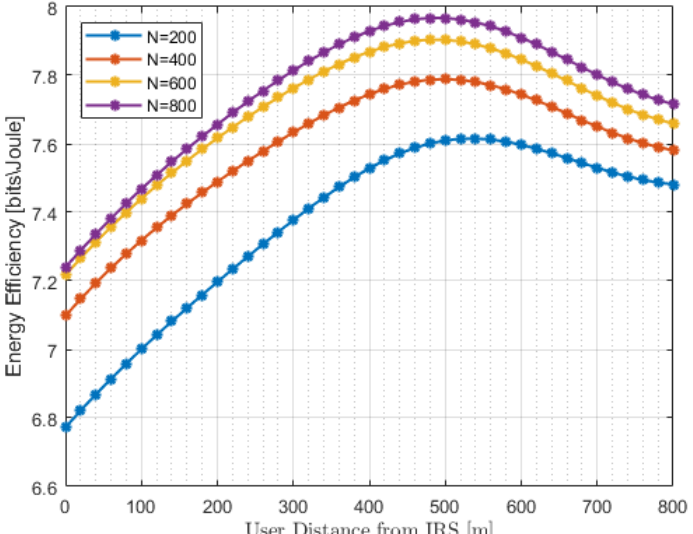
Figure 4. EE versus Distance with varying N.